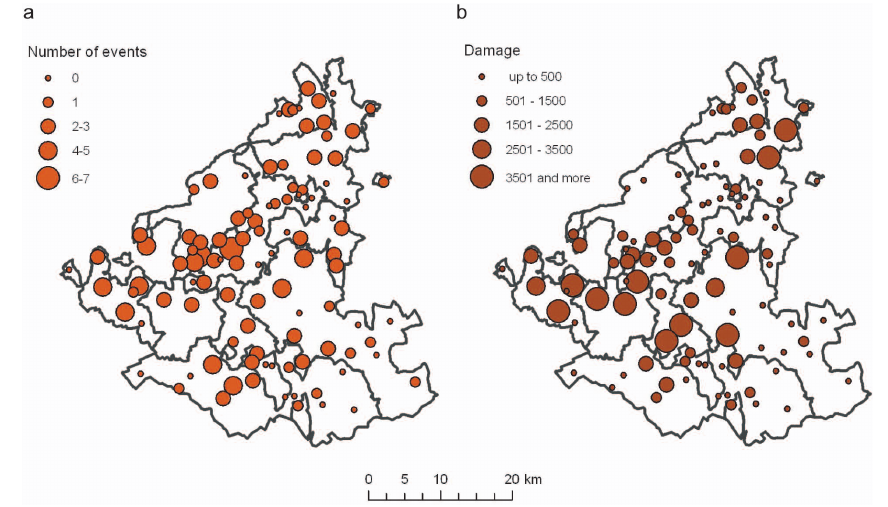
Fig. 8. Frequency of reported hailstorms doing damage to crops (a) and declared tax relief in crowns (b) during the 1896–1906 period expressed for individual settlements in the area